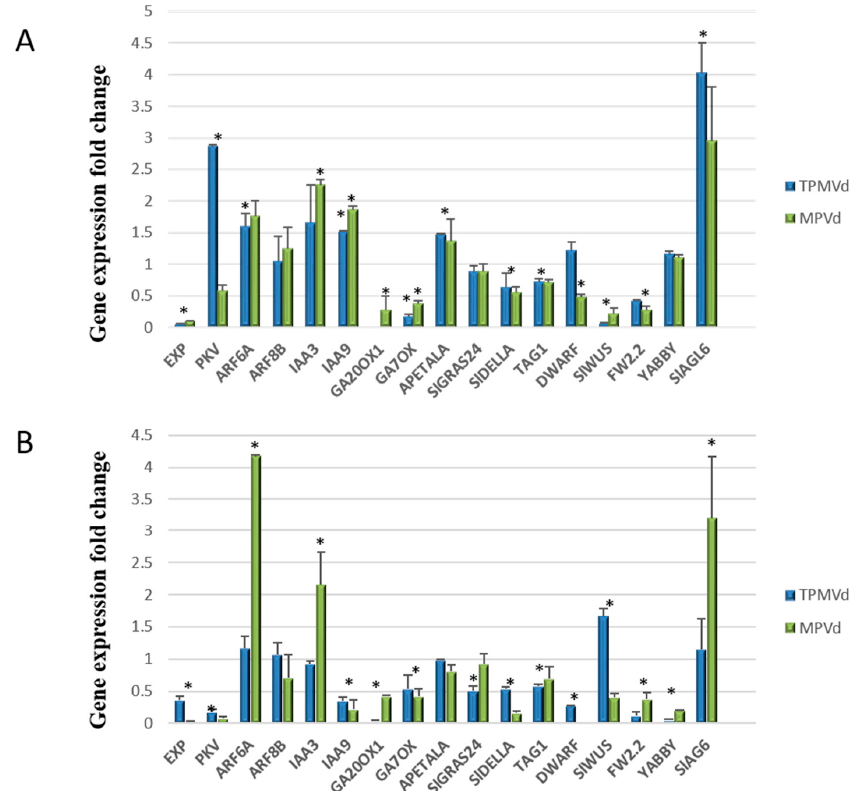
Figure 4. Relative mRNA accumulation of genes involved in leaf, flower, and fruit development in leaves ( A ) and flower buds ( B ) in TPMVd ‐ and MPVd ‐ infected tomato plants. Total leaf RNAs were